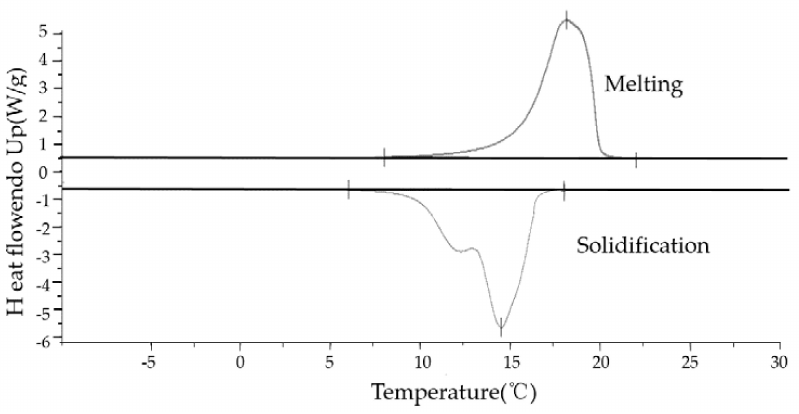
Figure 4. Microencapsulated phase change material (MEPCM) phase change process according to the Differential Scanning Calorimeter (DSC) testing